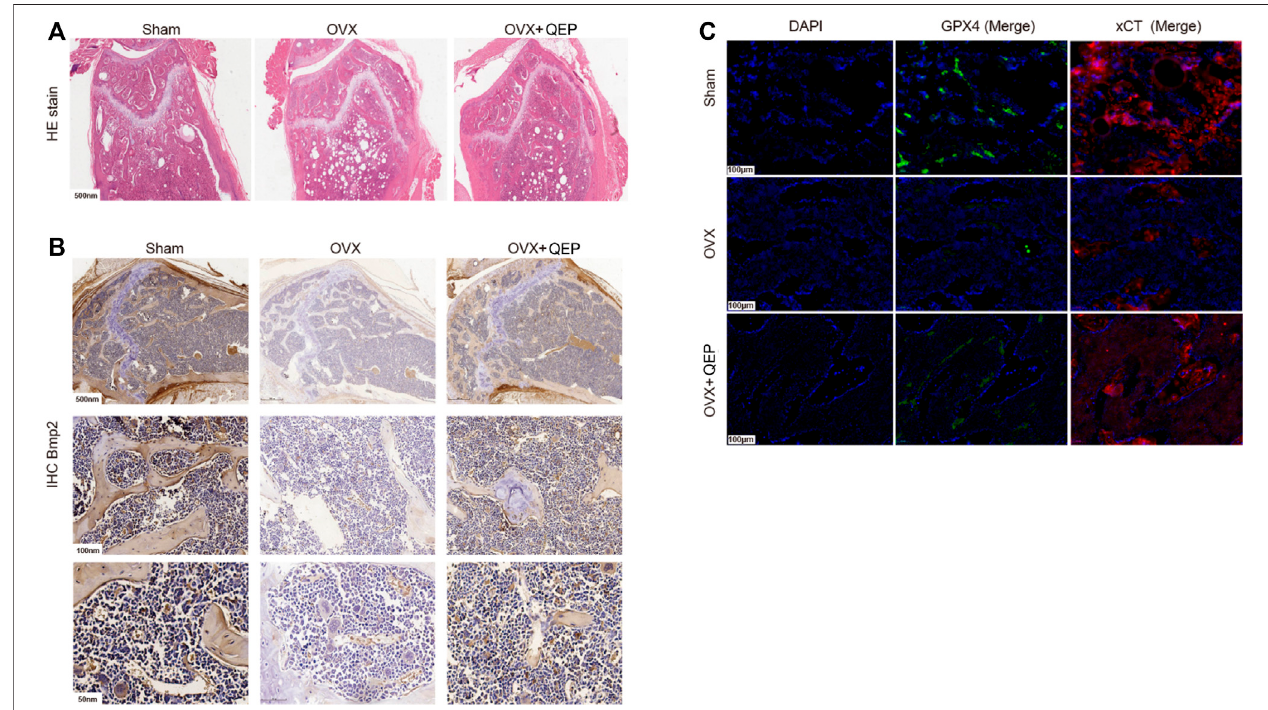
FIGURE 6 | QEP improved osteoporosis in OVX rats. (A) HE-stained sections of the tibia from different groups. (B) Tibia sections stained with Bmp2 for IHC analysis. (C) Tibia sections were stained with GPX4 and xCT for IF analysis (Sham, sham-operated group; OVX, ophorectomy group; OVX + Qing, treated with QEP in OVX